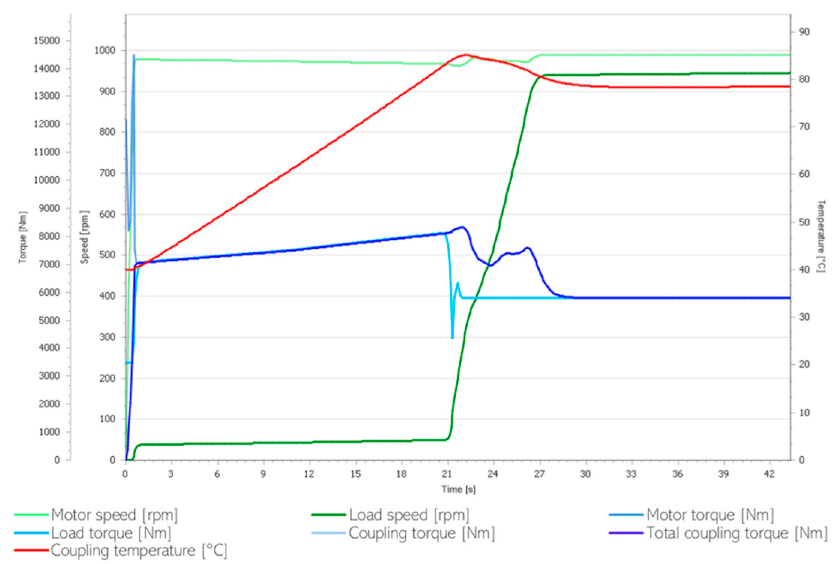
Figure 9. Dynamic simulation of the ball mill start-up process with the use of the TVV 866 fluid